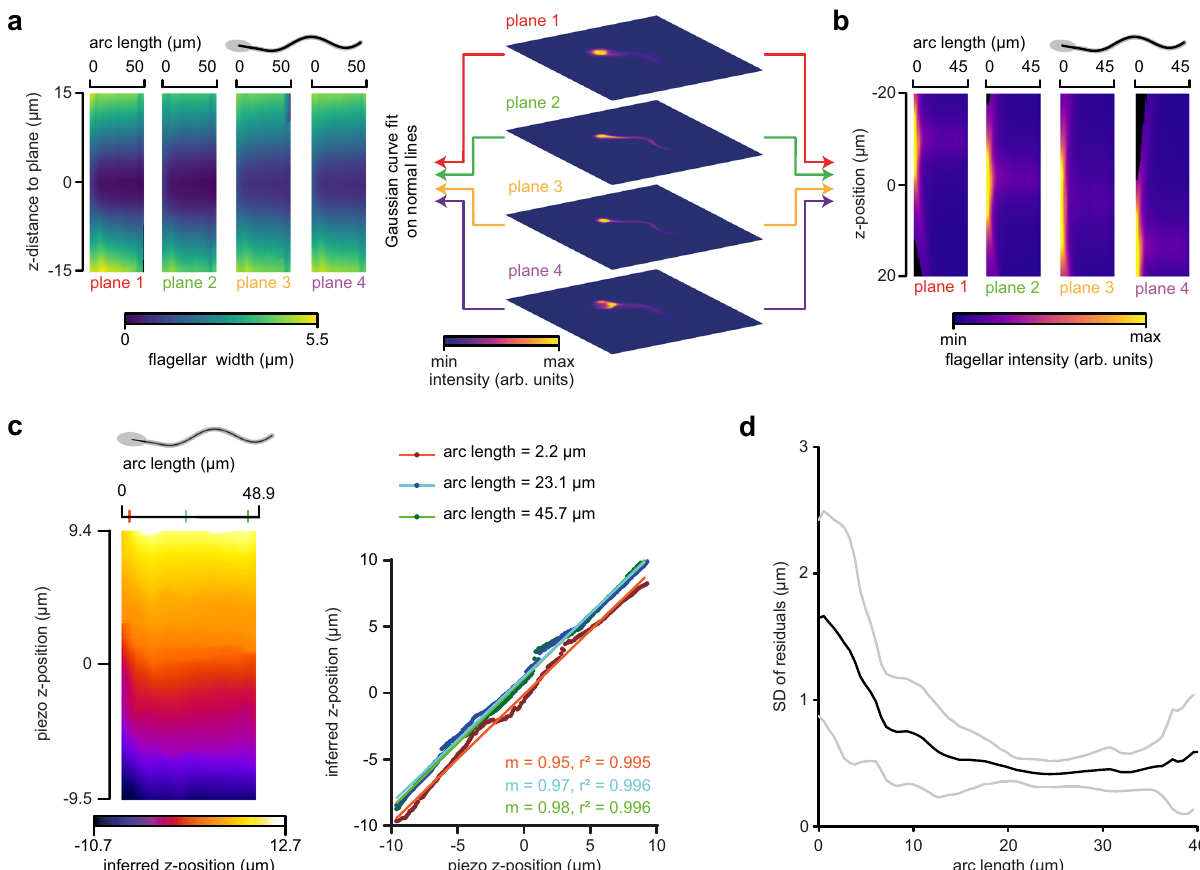
Fig. 3 Reconstructing fl agellar z -positions of human sperm using four focal planes. a, b Characterizing the relationship between image and z -position of human sperm fl agella in the MFI setup. a Flagellar width (color-coded), determined by a Gaussian curve fi t on a normal to the fl agellum, as a function of the fl agellar position (arc length) and the z-distance to the respective plane (mean image of n = 12 sperm from fi ve different donors). b Maximum fl agellar intensity (color-coded) as a function of the fl agellar position (arc length) and the z -position relative to the four planes. c z -position (color-coded) along the fl agellum (arc length) of an immotile human sperm cell inferred from MF images based on the calibrated relationship between the fl agellar width, position on the fl agellum, and z -distance to the respective plane during modulation of the objective z -position with a piezo (steps 0.1 µ m; left). Colored ticks on the arc-length axis mark fl agellar positions that are further analyzed by a linear curve fi t (right), revealing a linear relationship between the objective z -position and the z -position determined by MF image analysis (m: slope). d Standard deviation (SD) of the residuals of linear curve fi ts to data as exempli fi ed in c